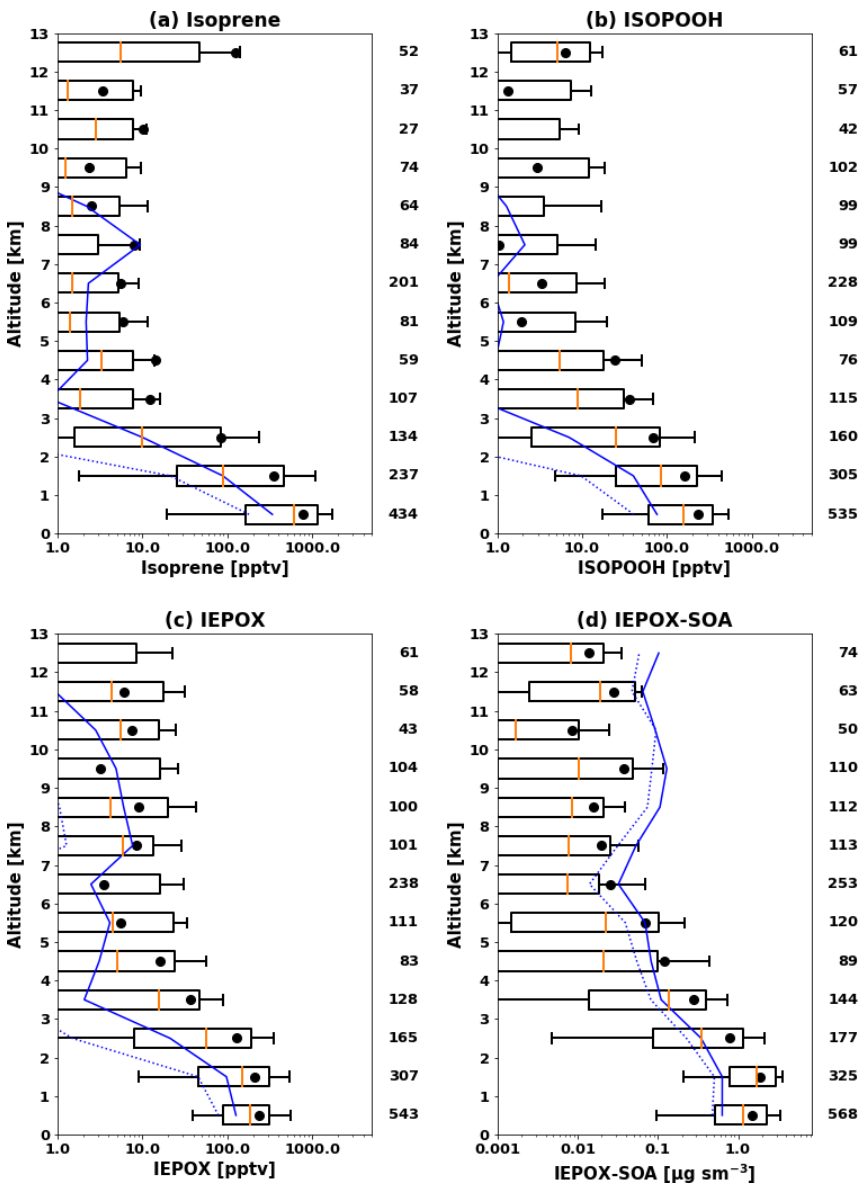
Figure 1. Vertical profiles of (a) isoprene, (b) ISOPOOH, (c) IEPOX, and (d) IEPOX SOA during the SEAC 4 RS campaign over the south- eastern US. Profiles are binned to the 1km vertical resolution grid. Boxes show the 25th–75th percentile, with the orange line being the median. Whiskers represent 10th and 90th percentiles, and the black dot indicates the mean value. The model results are sampled along the flight tracks and shown in blue, with the solid line for the mean and the dashed line for median values. The number of 60s merged data points in each kilometer interval is shown at the right of each